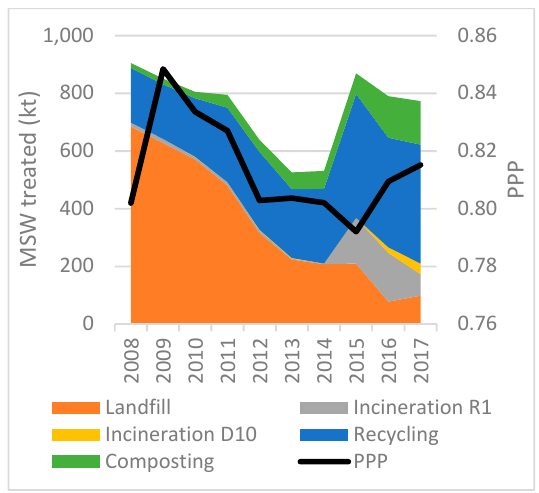
Figure 48. Waste treatment methods and PPP in Slovenia 2008–2017 (European Statistics 2019b, 2019c).